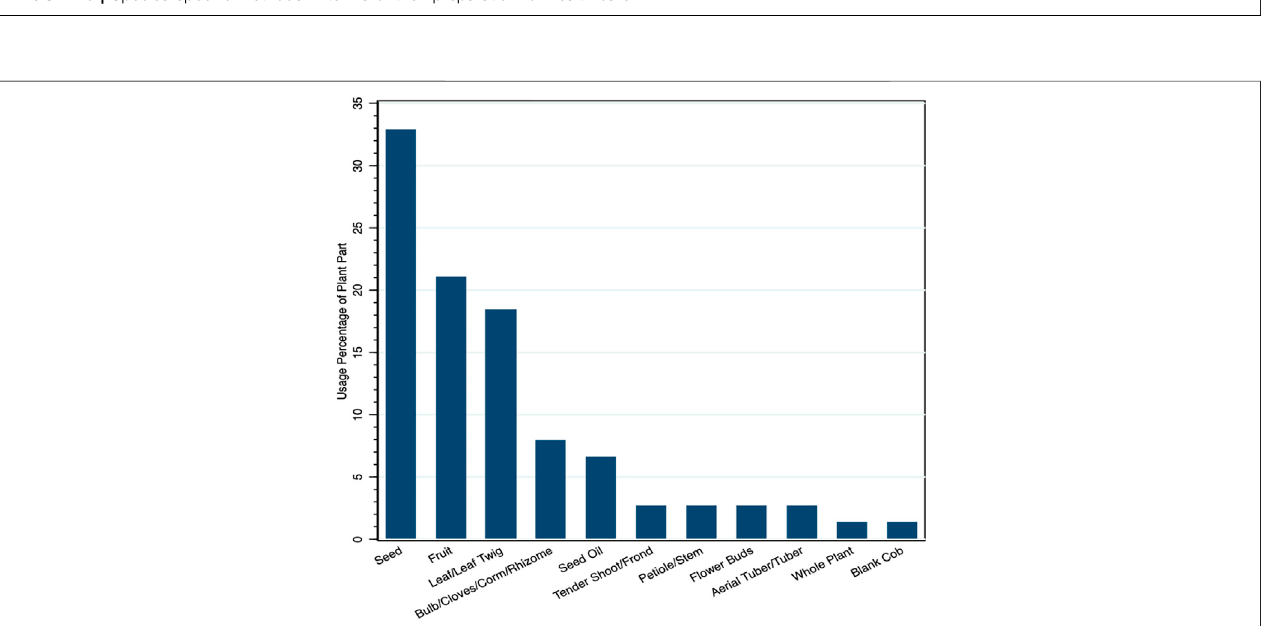
FIGURE 3 | Species-speci fi c methods in terms of their preparation for health care.